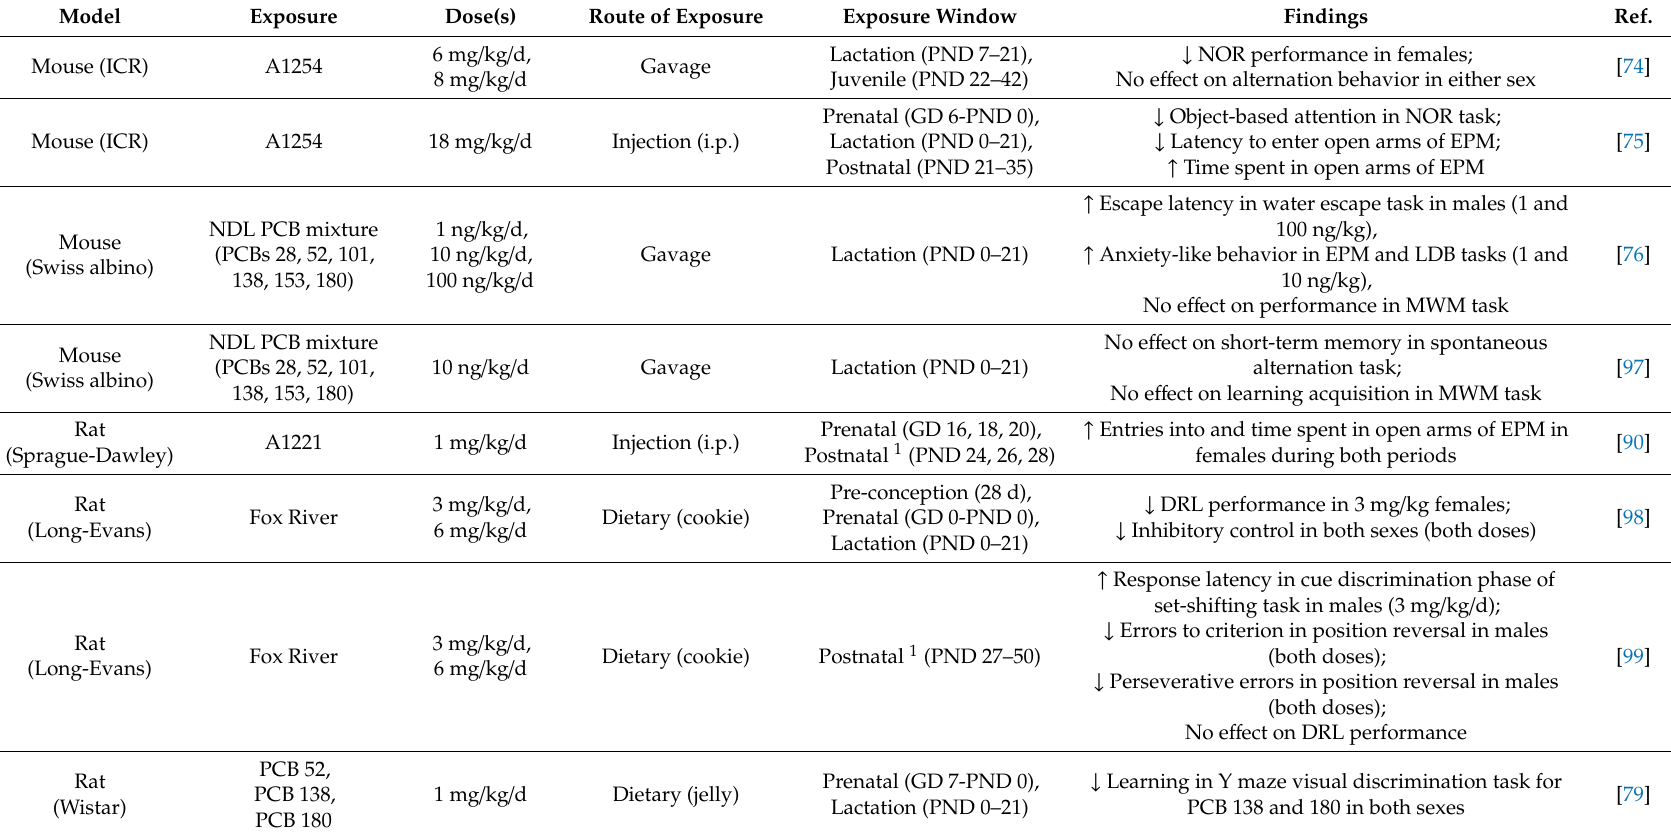
Table 3. E ff ects of developmental PCB exposure on cognitive behavior and executive